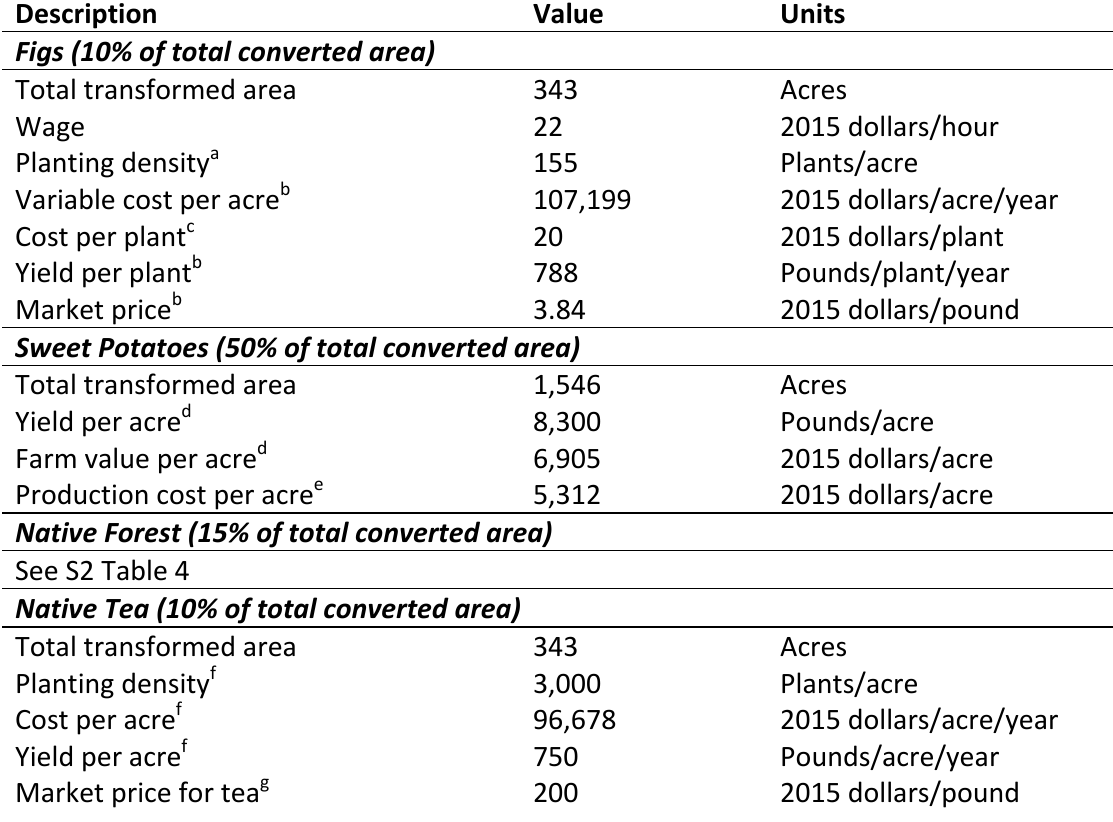
Table A1.10. Parameter descriptions and values for Hawaiian agroforestry